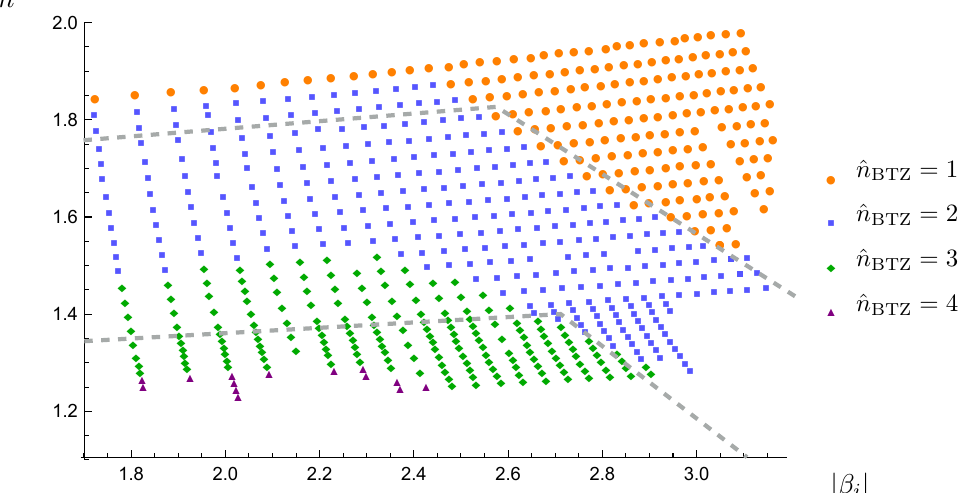
Figure 9 . Heuristic estimation of ^ n BTZ for di(cid:11)erent values of the moduli. We compare these values to the previously determined regions for n BTZ by drawing the dashed boundaries from (cid:12)gure